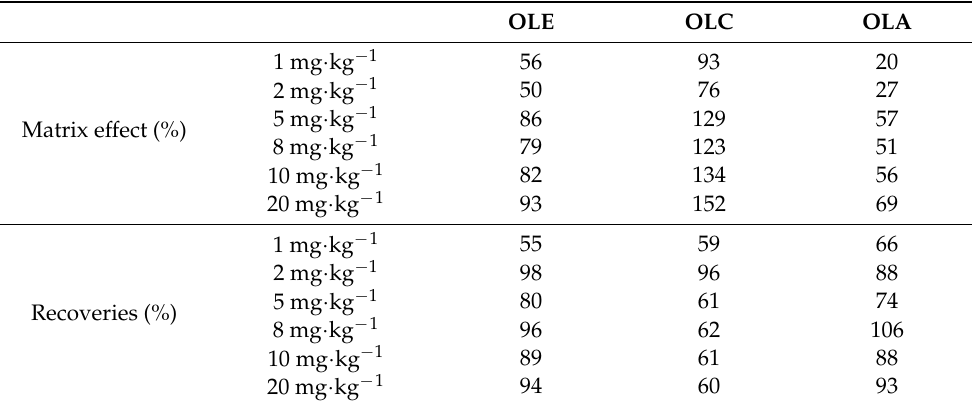
Table 4. Matrix effect and recoveries for OLE, OLC, and OLA.